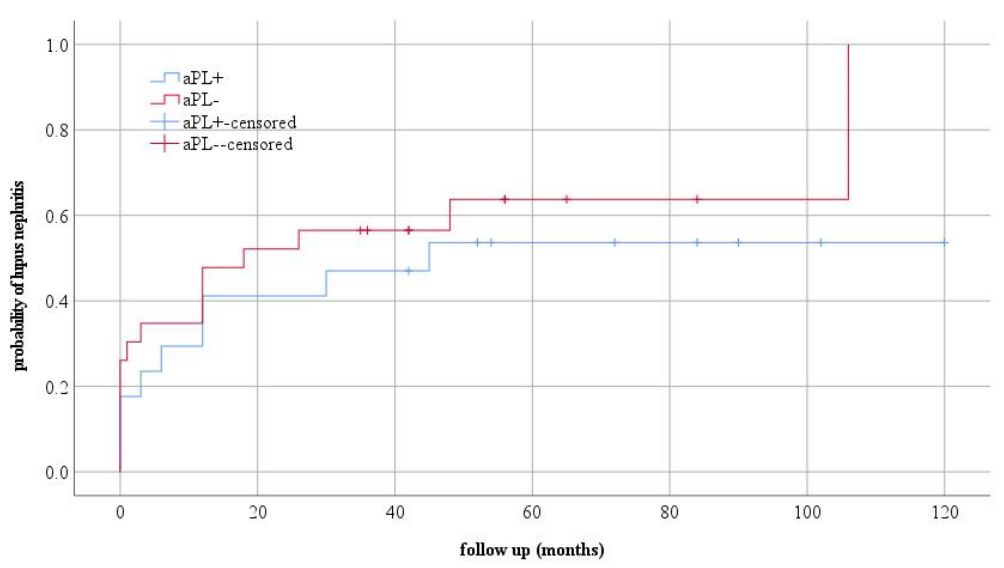
Figure 1. The probability of the occurrence of lupus nephritis and the clinical form of the disease.